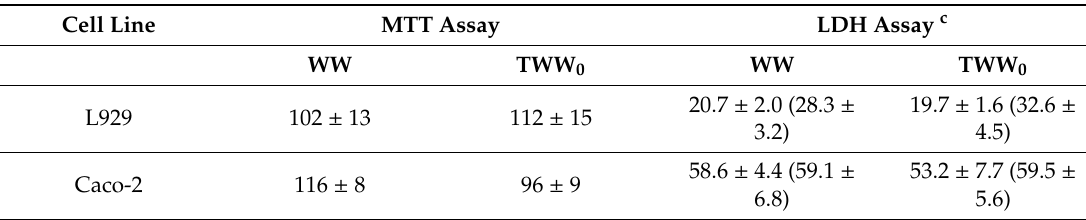
Table 3. Results (percentage) from MTT a and LDH b assays obtained for urban wastewater before (WW) and after treatment (TWW 0 ). Cell Line MTT